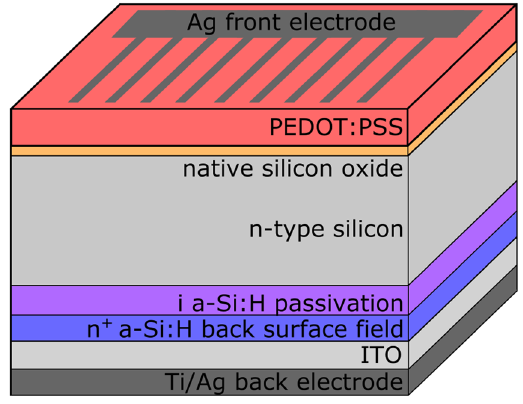
Figure 1. Schematic of the device structure of the PEDOT:PSS/c-Si/a-Si solar cells. On the backside of a mono- crystalline n-type Si wafer an intrinsic and a highly n-doped amorphous silicon layer as well as an ITO layer and Ti/Ag electrode are deposited. On the front side PEDOT:PSS is spin coated and as a front electrode an Ag-grid is